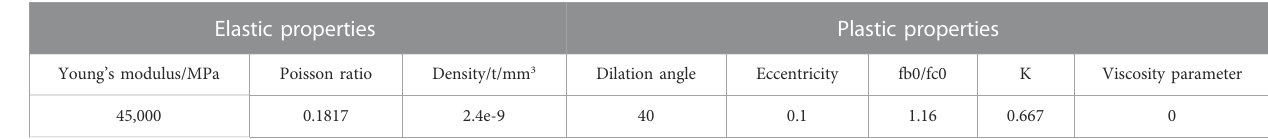
TABLE 4 Simulation parameters.